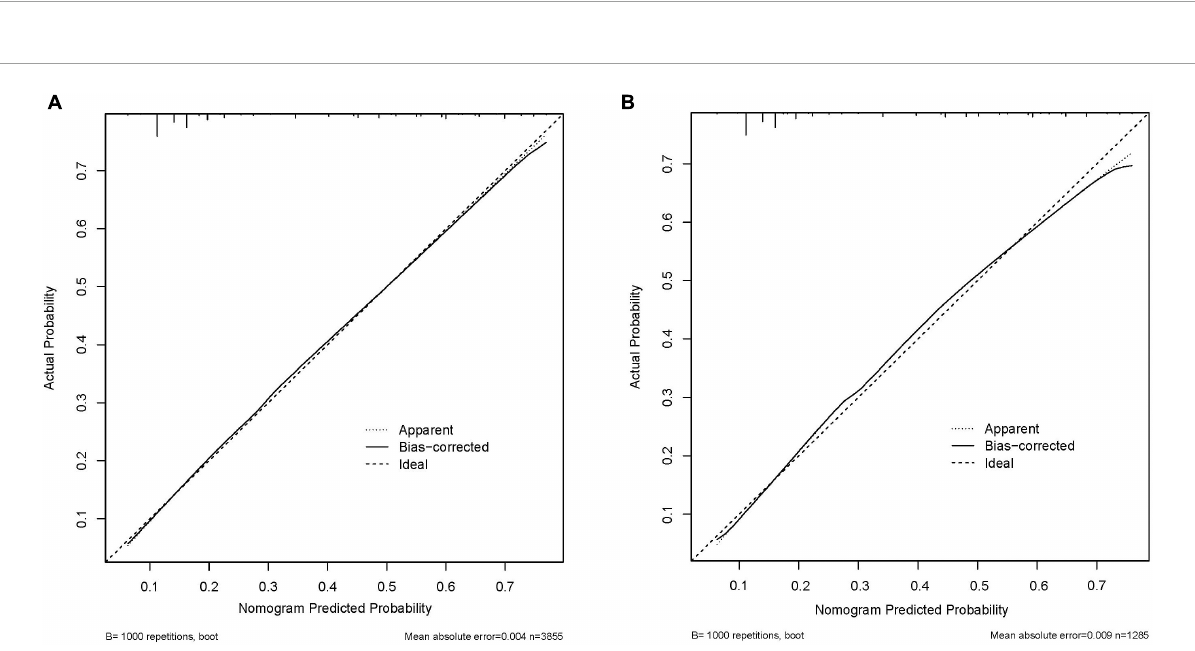
FIGURE3 The logistic calibration curve of the prediction nomograms of risk factors for poor sleep quality in medical students. (A) Calibration curve of the poor sleep quality nomogram prediction in the training set. (B) Calibration curve of the poor sleep quality nomogram prediction in the validation